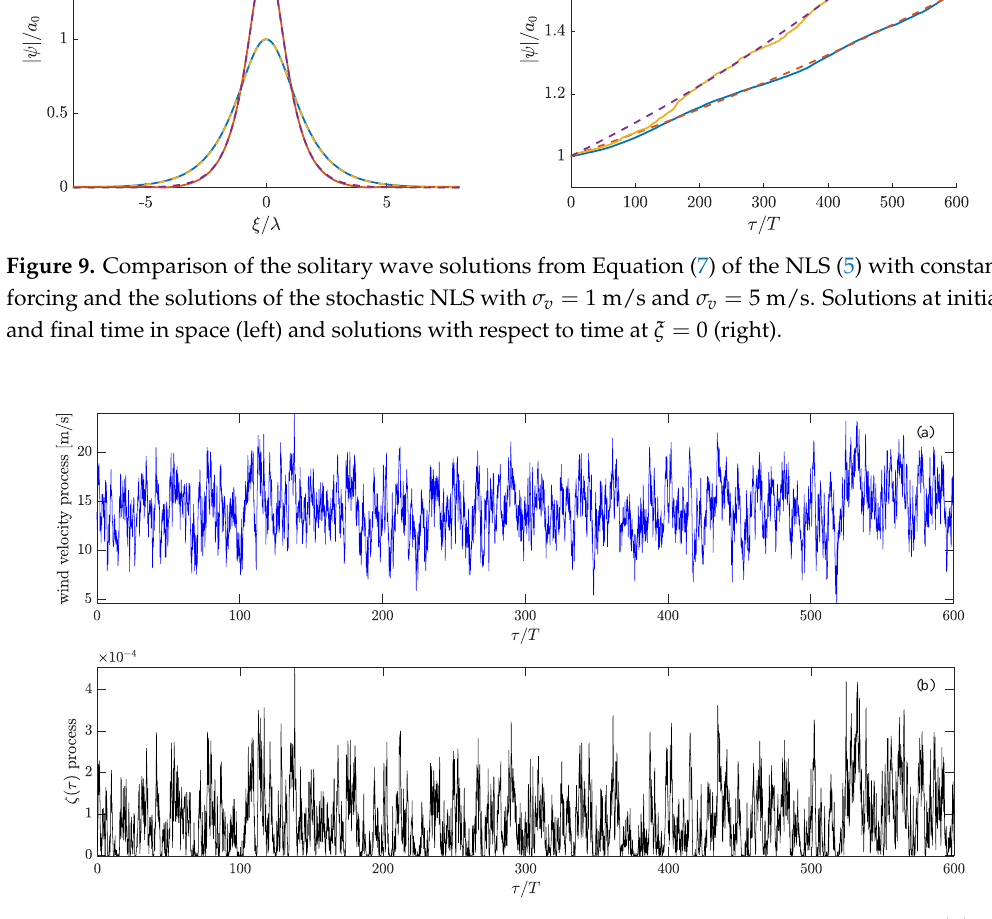
Figure 10. Wind velocity process and corresponding time dependent random forcing process ζ ( τ ) for V m = 14 m/s and σ v = 5